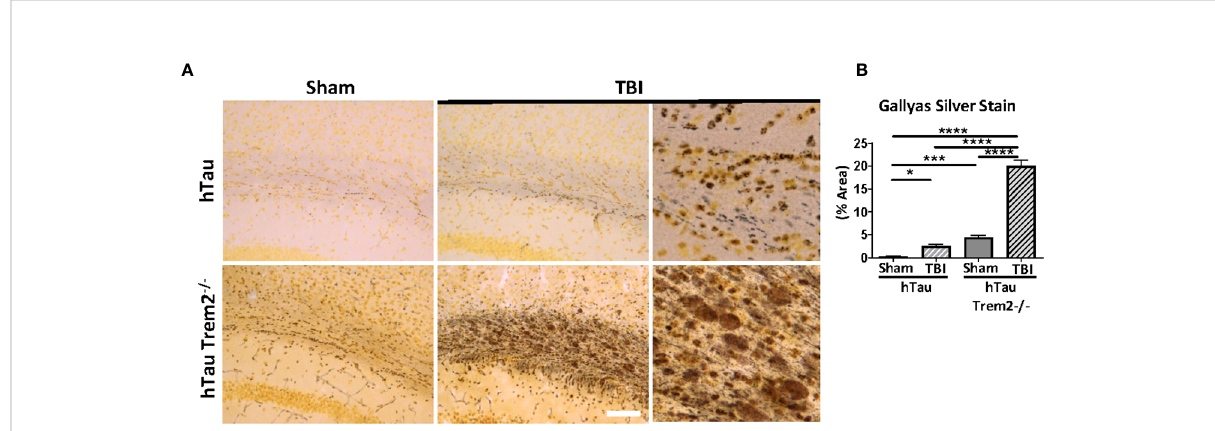
FIGURE 4 Prominent tau aggregation in the white matter near injury site in injured hTau; Trem2 -/- mice in chronic phase. (A) Aggregated tau was identi fi ed using Gallyas silver staining. Images were acquired in the external capsule near the lesion site in hTau and hTau; Trem2 -/- mice with or without TBI. (B) Silver staining was signi fi cantly enhanced in the white matter of hTau; Trem2 -/- TBI mice compared with hTau TBI mice. All experiments used n = 6 (equal males and females) mice per group unless otherwise noted. At least two independent experiments were performed for each analysis. The scale bar represents 50 m m. Error bars indicate SEM; * p <0.05, *** p <0.005, **** p <0.001.